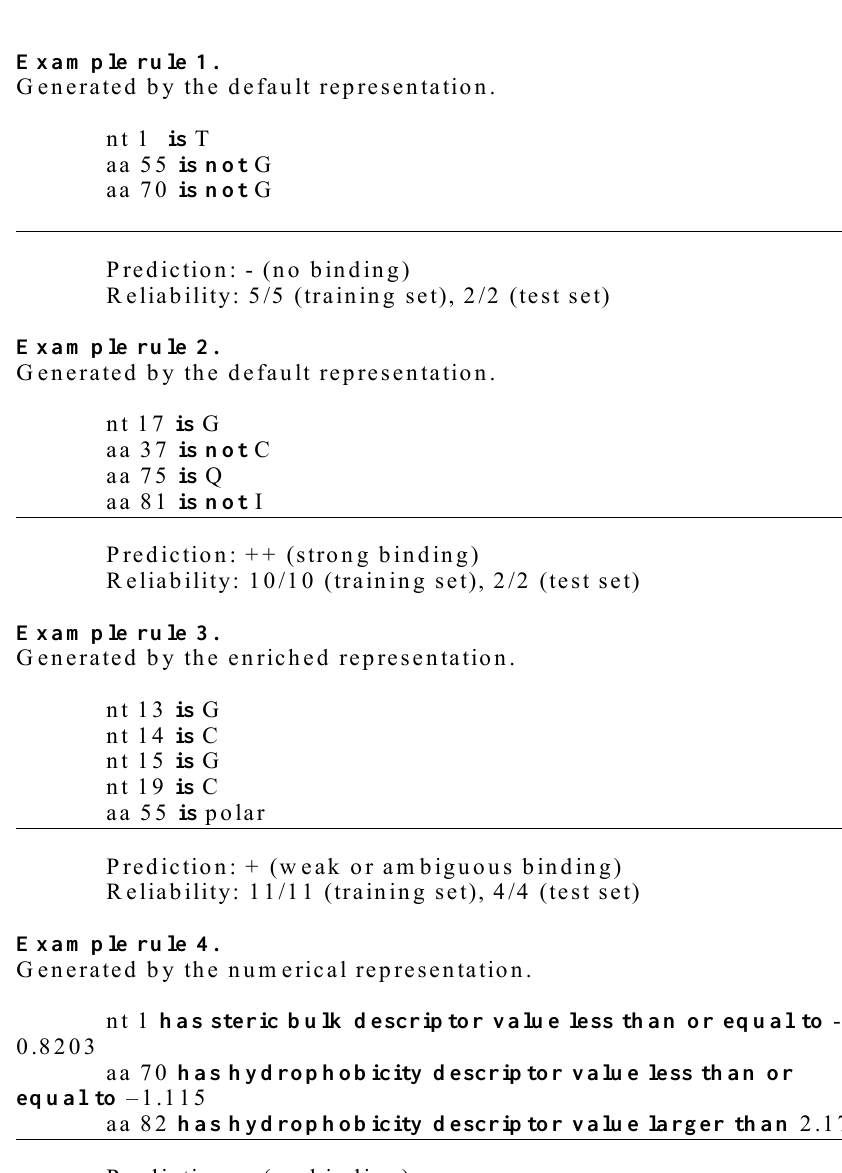
Figure 2. Paired domain decision rule examples. The decision rules were extracted with high prediction accuracy, and were generated using three different data representations in RDS. Note that all rules use both nucleotides (nt) and amino acid (aa) residues to predict binding strength. The rules consist of logical statements involving the nucleotide and amino acid positions. In the default representation, only the identity of each amino acid or nucleotide is considered. In the enriched representation, each amino acid is also described with attributes relating to hydrophobicity, charge, aromaticity, and special characteristics. Thus, rules generated using this representation can contain logical relations of the form “amino acid 2 is hydrophobic”, in addition to rules involving residue identities. In the numerical representation, nucleotides and amino acid residues are encoded by numerical biophysical descriptor values, which are then used to generate rules. The three nucleotide descriptors roughly represent size, electronic properties and hydrophobic properties, and the three amino acid descriptors roughly correspond to a hydrophobicity measure, a steric bulk measure, and a polarity measure [10, 57]. In this case, rules are not of the form “X is Y” or “X is not Y”, but of the form “X is larger than Y” (or “X is larger than or equal to Y”) or “X is smaller than Y” (or “X is smaller than or equal to Y”). The Predictions line shows the predicted binding class for examples matching the rule shown. The Reliability line lists the performance of the rule on example cases in the training set (which consists of a randomly selected 80% of the examples) and the test set (which consists of the remaining